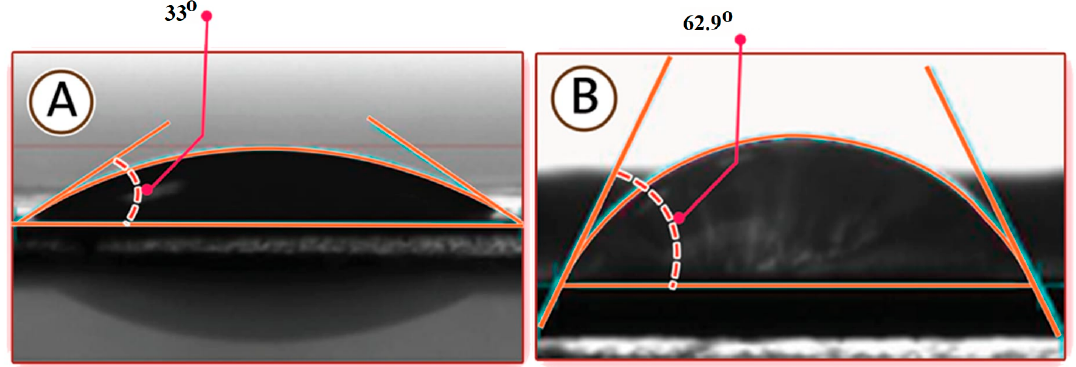
Figure 4. Contact angles of ( A ) water and ( B ) oil on the membrane surface .